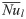
Effect of aspect ratio A and the porous matrix on Nu¯l for selected inclination angles.